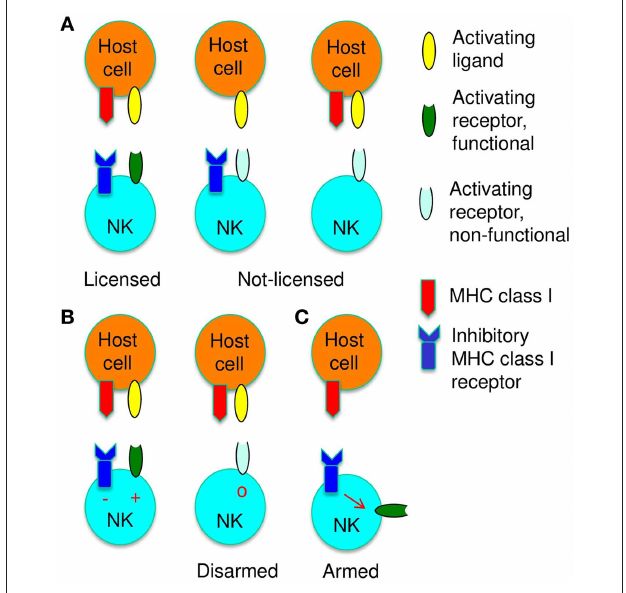
FIgure 1 | Functional adaptation of NK cells to self-MHC class I is shown. (A) NK cells are licensed, i.e., their activation receptors respond efficiently to stimulation (dark green) when NK cells can bind MHC class I. When the host lacks MHC class I molecules (middle) or when NK cells lack MHC class I receptors (right), activation receptors respond poorly to stimulation (light green), i.e., NK cells are not licensed. (B) Activation pathways are disarmed when NK cells are chronically stimulated in the absence of inhibitory signals from MHC class I receptors. (C) Signals from MHC class I receptors arm NK cells, i.e., instruct NK cell activation pathways to become responsive.